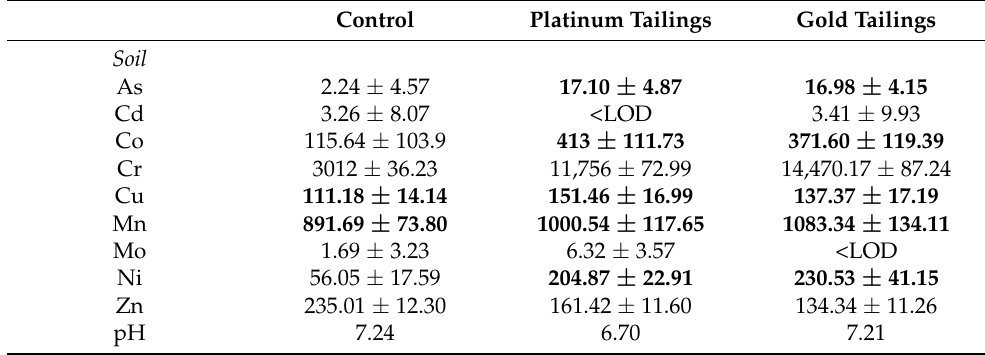
Table A1. PTMs concentrations (Mean ± Std) in soil, A. Burgersfortensis and A. Castanea leaves under the study treatments. Values in bold are above permissible limits